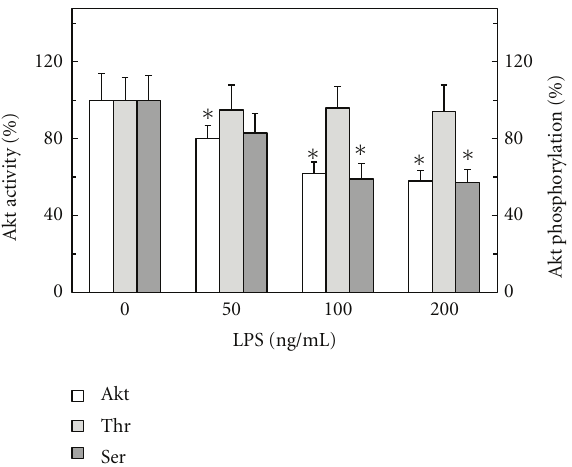
Figure 2: E ff ect of P. gingivalis LPS on Akt kinase activity and its phosphorylation on threonine (Thr 308 ) and serine (Ser 473 ) in rat sublingual salivary gland acinar cells. The cells were treated with the indicated concentrations of the LPS and incubated for 16 h. ∗ P < . 05 compared with that of control (LPS − 0).